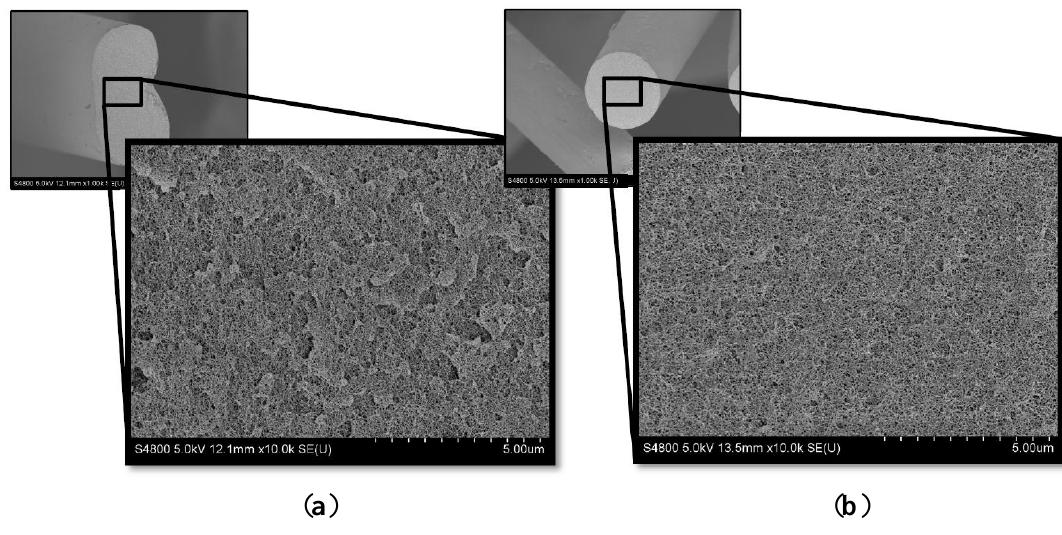
Figure 9. High resolution SEM images of freeze dried, cryo-fractured fiber from the coagulation bath (sampling point I) at varying bath concentrations. ( a ) 57.8 wt% DMAc/H 2 O; ( b ) 79.0 wt% DMAc/H 2 O.